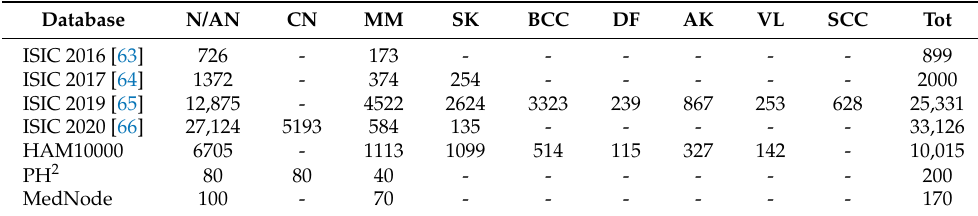
Table 2. Summary of the most common public skin lesion datasets, which contain images of nevi (N)/atypical nevi (AN), common nevi (CN), malignant melanomas (MM), seborrheic keratoses (SK), basal cell carcinomas (BCC), dermatofibromas (DF), actinic keratoses (AK), vascular lesions (VL), and squamous cell carcinomas